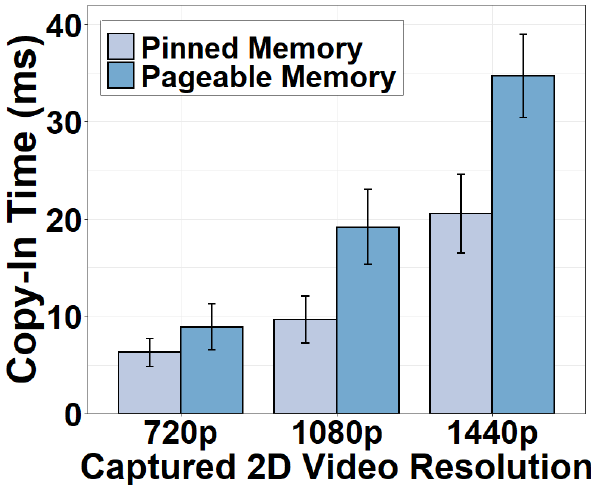
Figure 4. Copy-in time using different memory types.